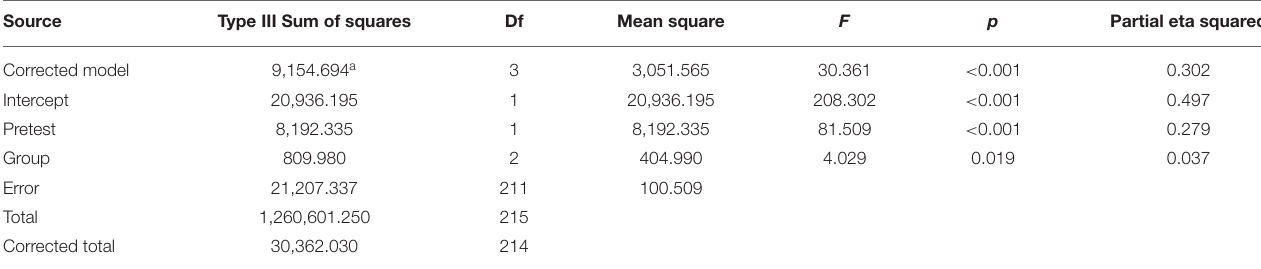
TABLE 3 | ANCOVA tests of between-subjects effects at post-test for writing performance.